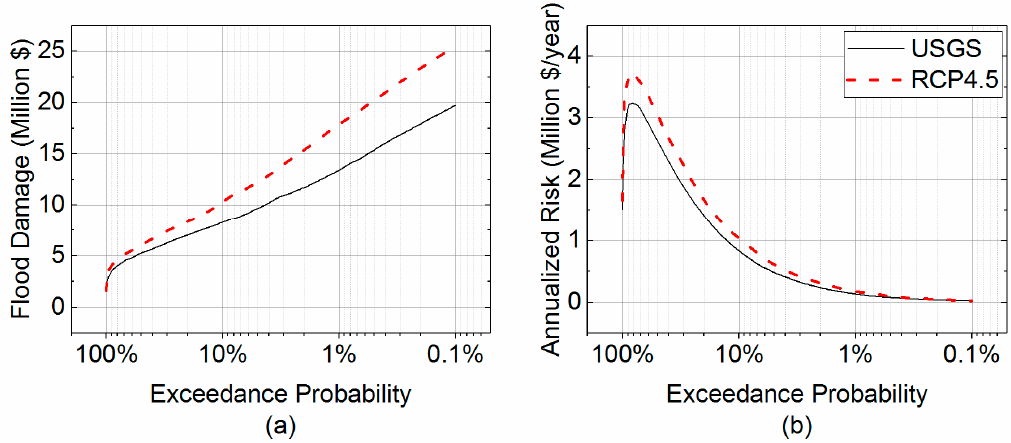
Figure 9. The damage ( a ) and annualized risk ( b ) of USGS and RCP4.5 flow conditions.